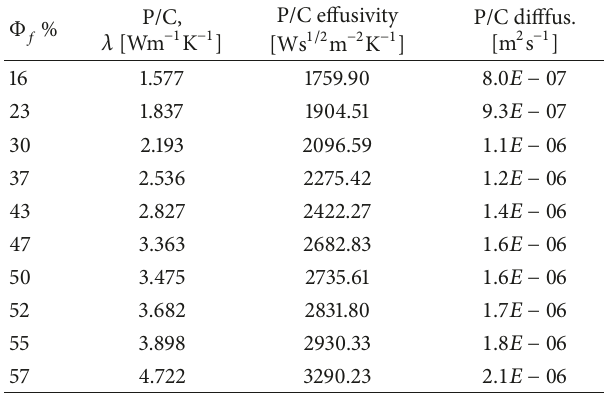
Table 3: Thermal conductivity, effusivity, and diffusivity change with filler content .